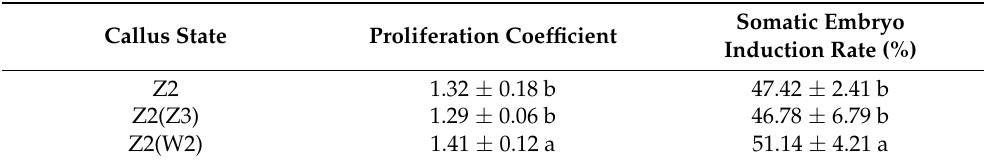
Note: The data are expressed as the mean ± SE. Lowercase letters in the same column represent significant differences at p <